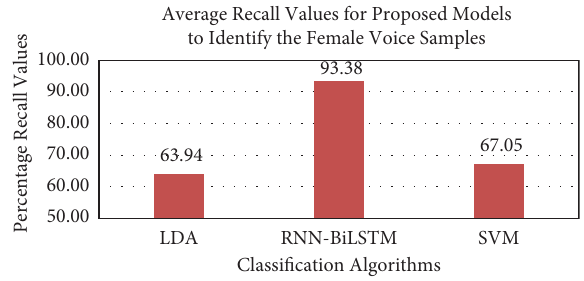
Figure 4: Average recall value for proposed models to identify the female voice samples.